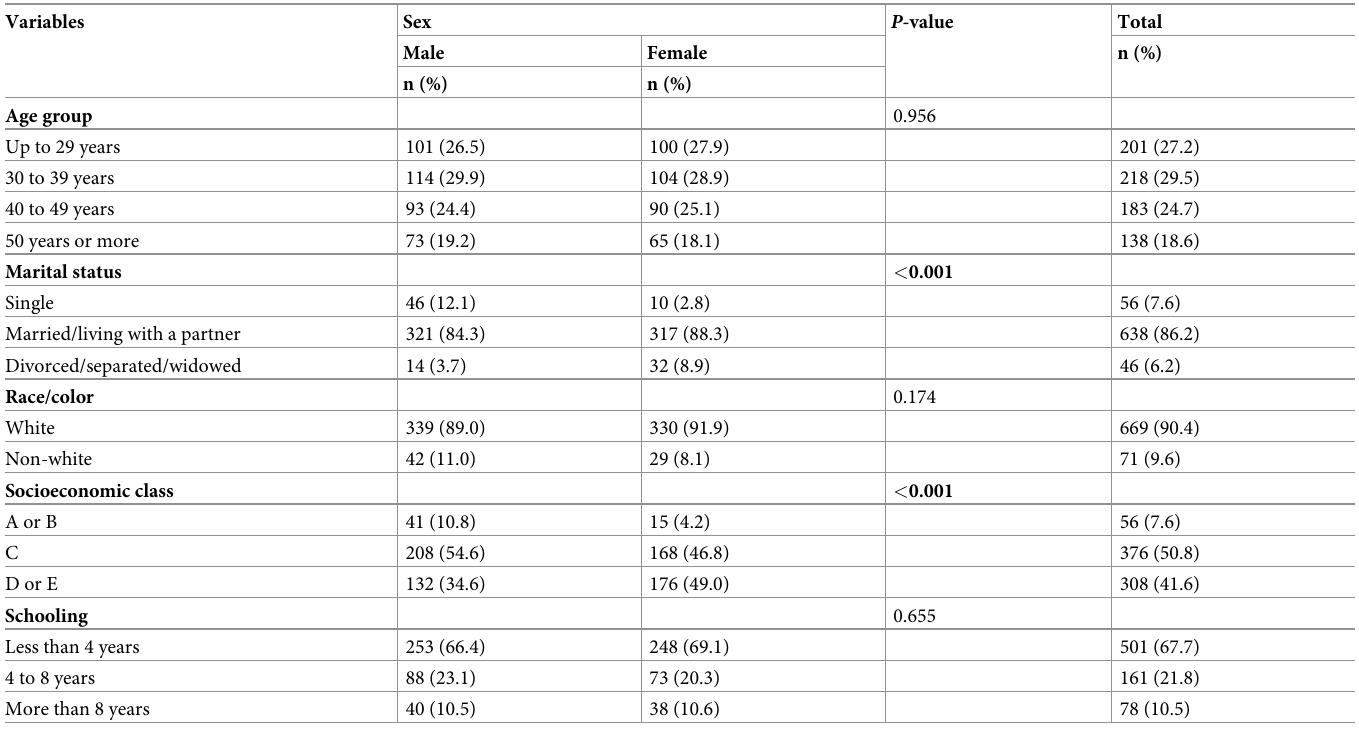
Table 1. General characteristics of study population, by